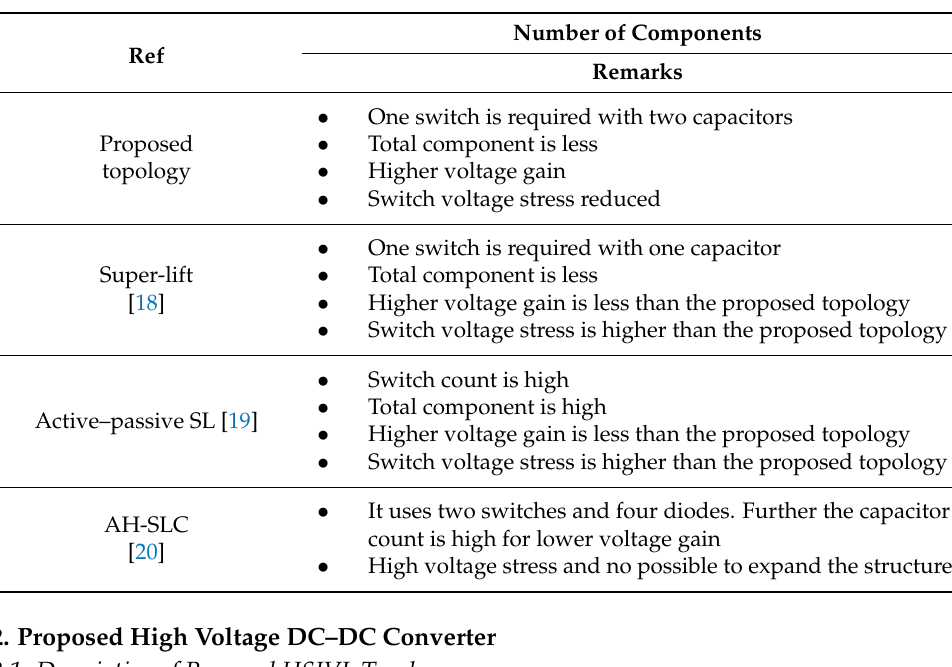
Table 1. Comparison of proposed converter with the literature.